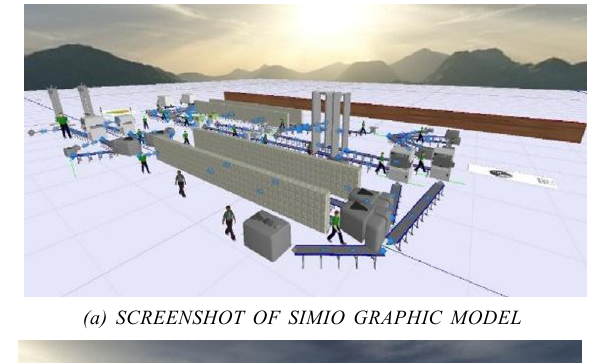
(a) SCREENSHOT OF SIMIO GRAPHIC MODEL